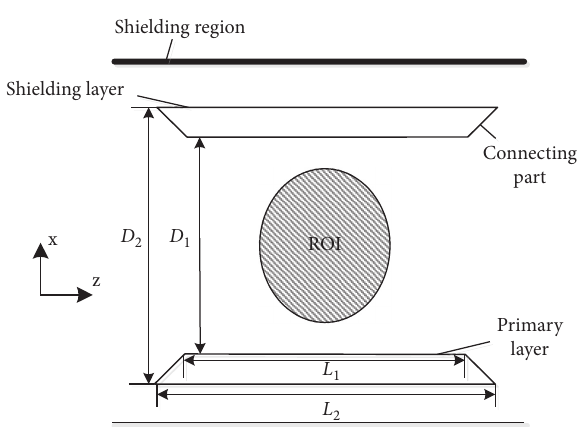
Figure 1: The cross section of the edge-connected cylindrical gradient coil. Gradient coil is distributed on the cylindrical surfaces including the primary layer, the shielding layer, and the connecting